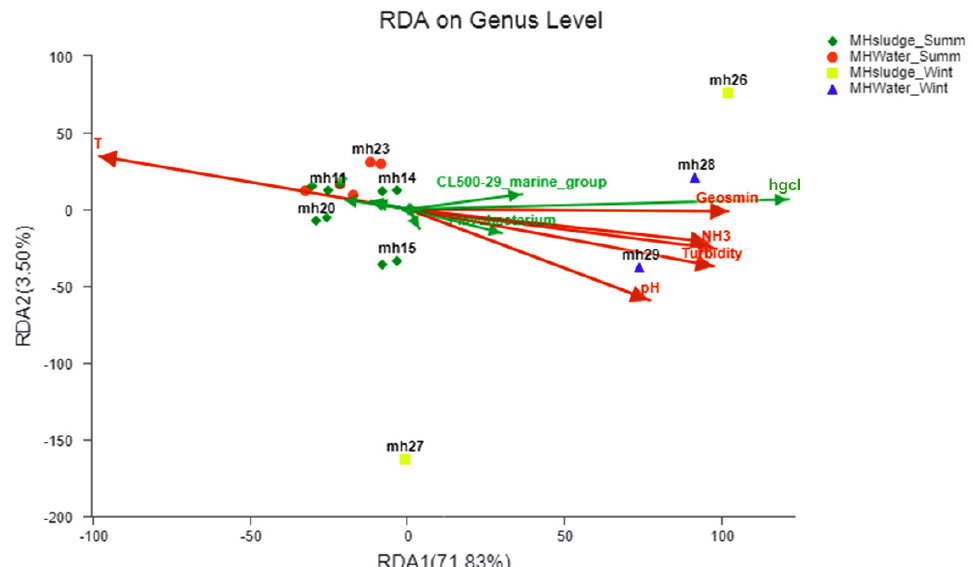
Figure 5. RDA analysis of the samples and environmental factors, as well as the genera (red arrow, environmental parameters; green arrow, genera).